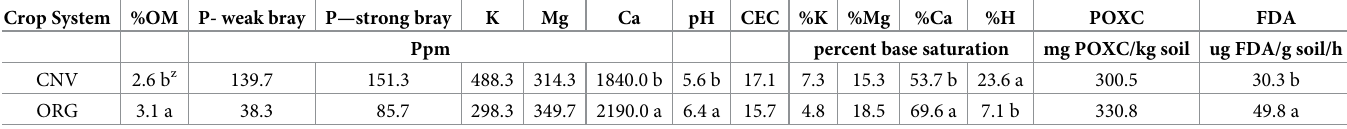
Table 2. Soil chemical properties and microbial activity in carrot field managed using organic and conventional farm practices just prior to planting in summer 2014 at Purdue’s Meigs Horticulture Research Farm. Crop System %OM P- weak bray P—strong bray